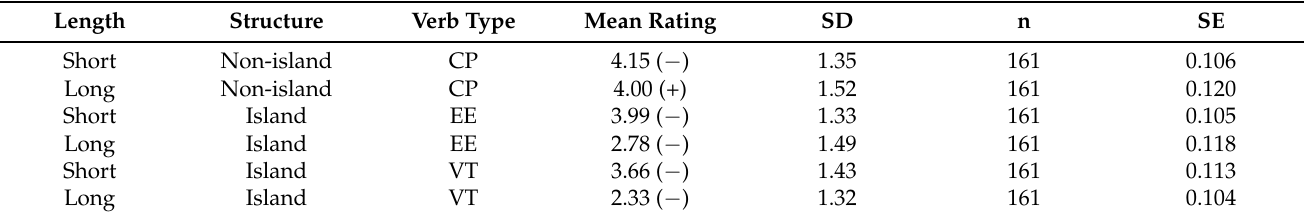
Table A4. Descriptive statistics for Experiment 2 burn-in trial results. A + or − in the rating cell (respectively) represents a higher or lower mean score for that condition in the burn-in trials than in the main trials. Mean is calculated on raw (non-z-scored)